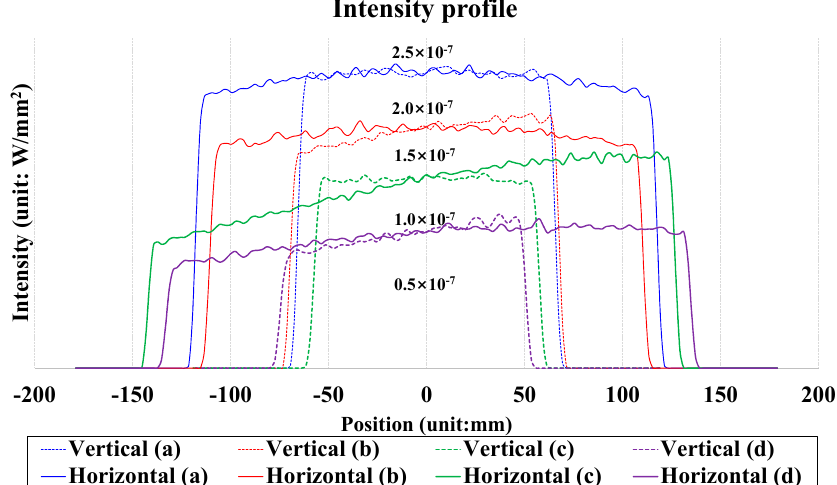
Figure 7. Intensity profiles corresponding to all four target locations and obtained using the fisheye lens system. The intensity profiles in the ( a ) vertical and horizontal directions when a LED light place was placed in the center position, intensity profiles in the ( b ) vertical and horizontal directions when a LED light place was placed in the horizontal position, intensity profiles in the ( c ) vertical and horizontal directions when a LED light place was placed in the vertical position, and intensity profiles in the ( d ) vertical and horizontal directions when a LED light place was placed in the diagonal position.